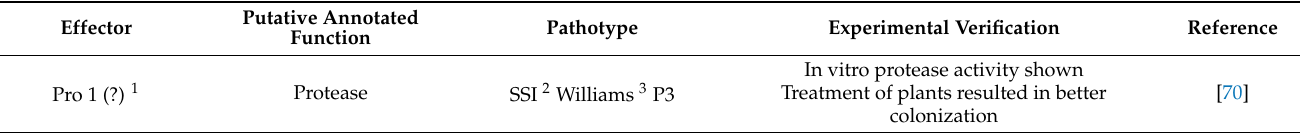
Table 2. Summary of Plasmodiophora brassicae proteins, including putative effectors, identified so far and their possible